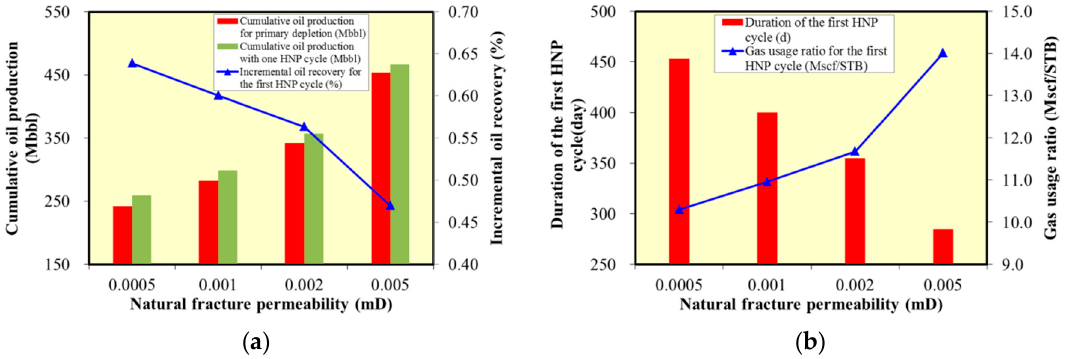
Figure 16. Correlation between natural fracture permeability and huff-n-puff results: ( a ) Cumulative oil production and incremental oil recovery for different natural fracture permeability; ( b ) Duration of the first huff-n-puff cycle and gas usage ratio for different natural fracture permeability.